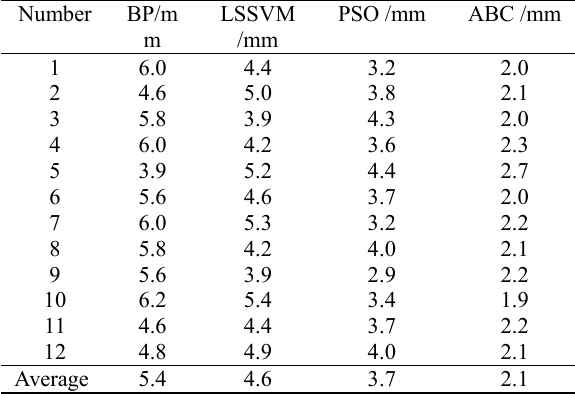
Table 1. Comparison of internal precision of constructed model The results of the table statistics show that in the 12